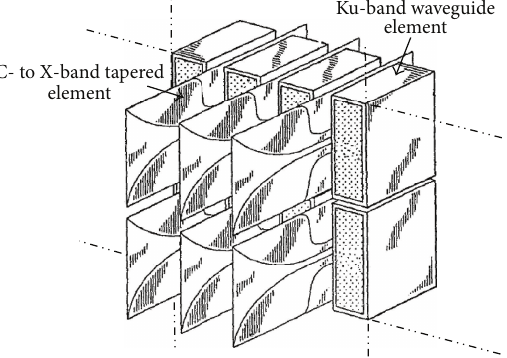
Figure 25: Multiband phased-array antenna with interleaved ele- ments